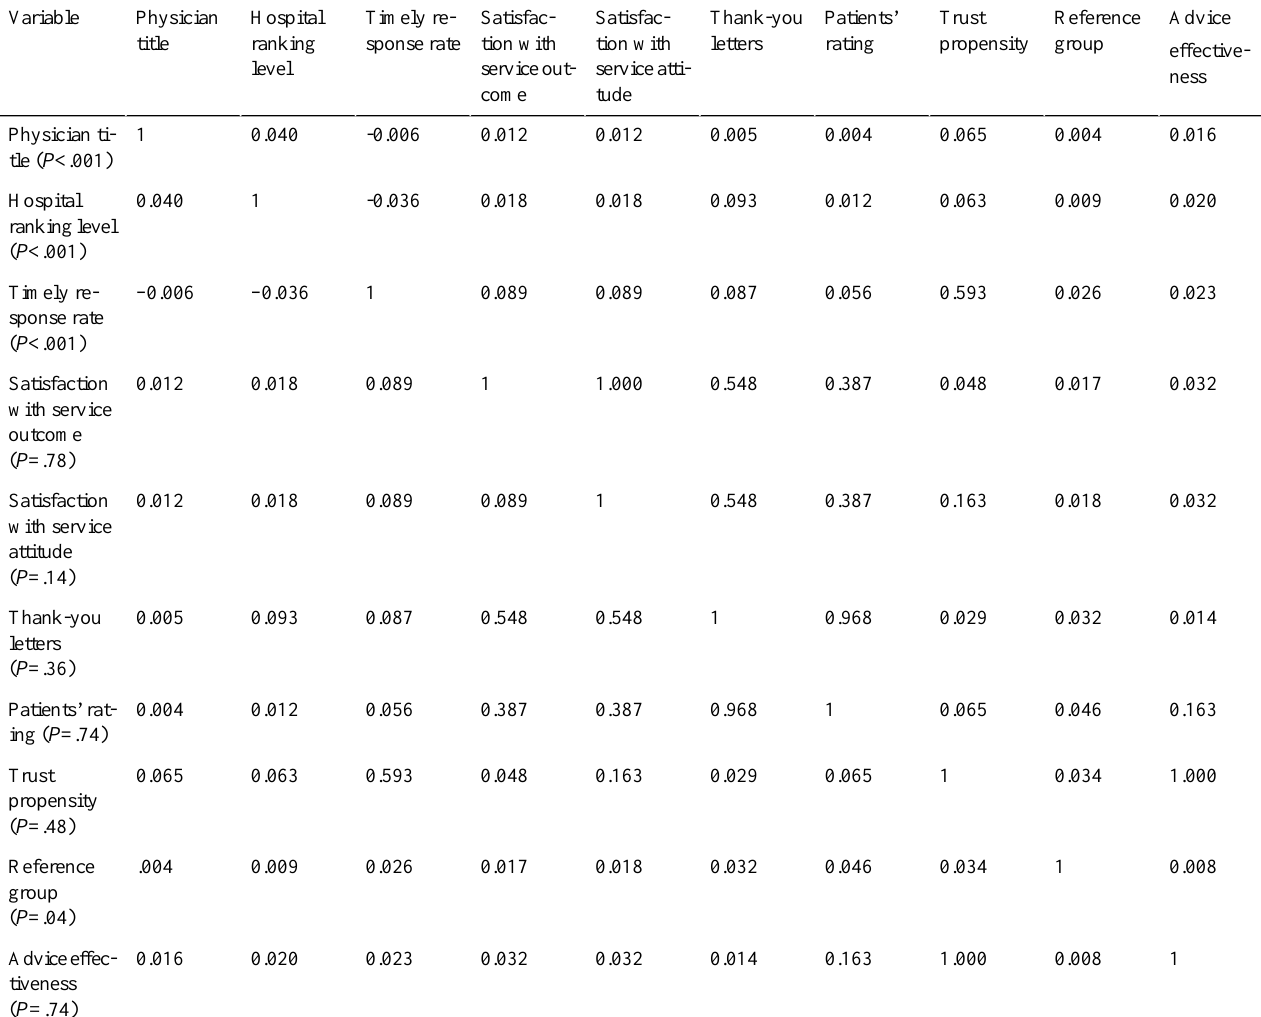
Table 3. Spearman correlation analysis of all variables (significance level=.05), r.